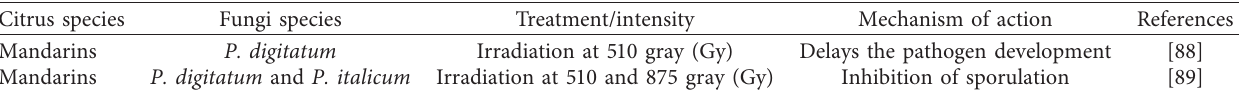
Table 5: Effects of X-ray irradiation on the postharvest rotting caused by P. italicum and P. digitatum